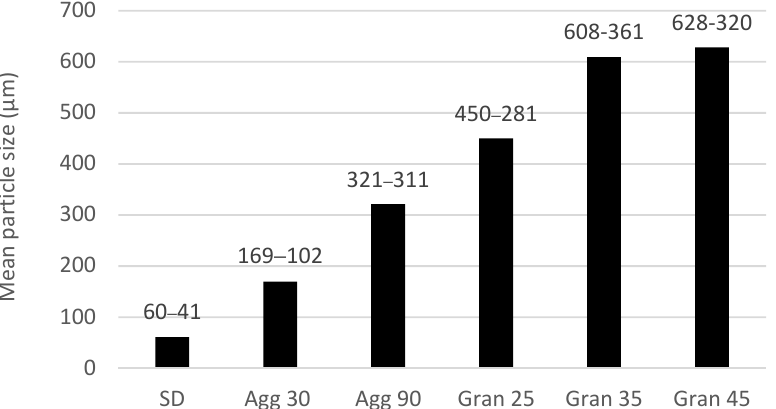
Figure 2. Influence of process (SD—spray dry; Agg xx—agglomeration min; Gran xx—granulation min) (values denote an average value of the mean particle sizes ( μ m) and standard deviations ( μ m) obtained for the duplicate runs).